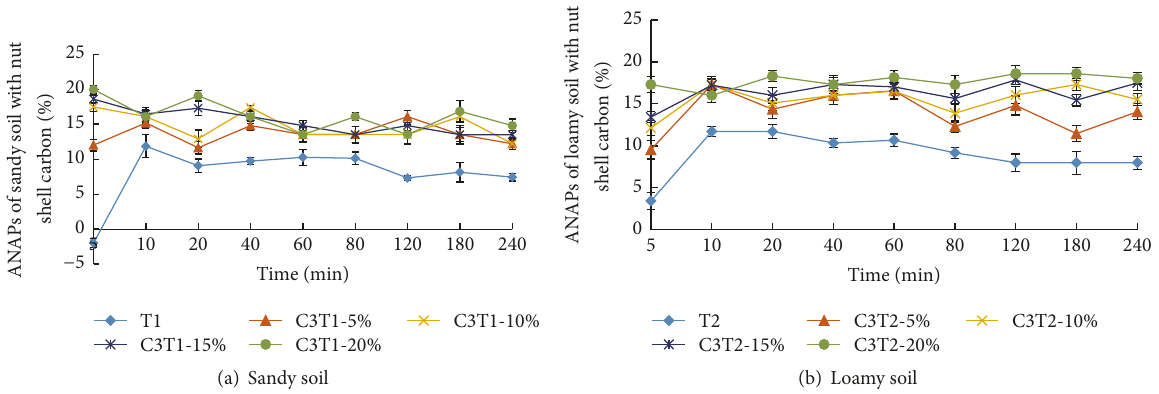
Figure 5: Effects of nut shell carbon (C 3 ) on soil adsorbing NH 4+ -N in biogas slurry.